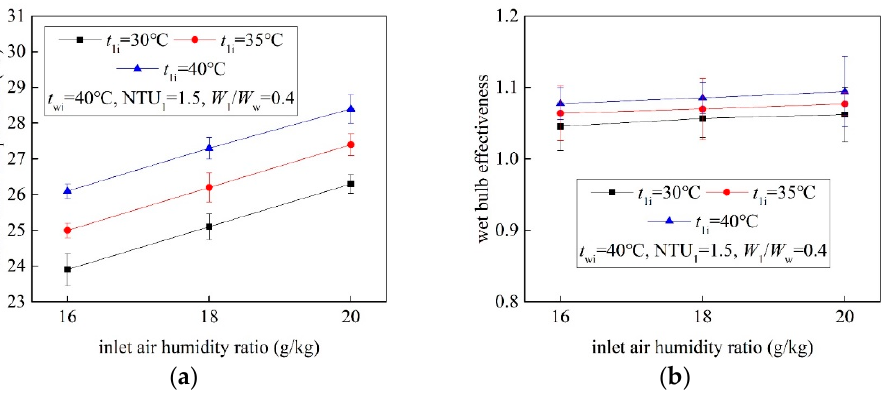
Figure 8. Impact of the inlet air humidity ratio on the performance of the MCT: ( a ) x 1i vs. t wo ; ( b ) x 1i vs. ε WB .